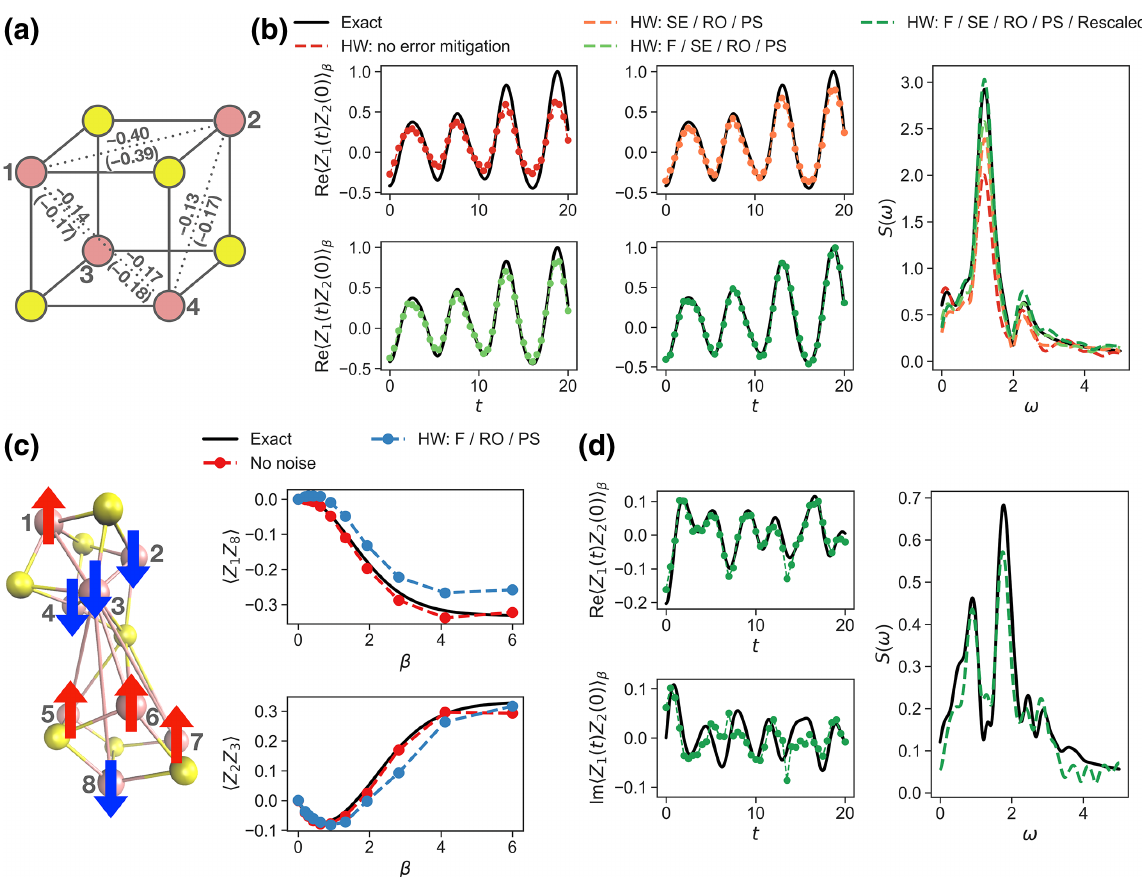
FIG. 3. (a) The finite-temperature (cid:2) Z i Z j (cid:3) ( β = 2) correlation functions computed for the [4Fe-4S] model. The simulation values are in good agreement with the exact results in parentheses. (b) The finite-temperature dynamical correlation function (cid:2) Z 1 ( t ) Z 2 ( 0 ) (cid:3) β ( β = 2) and its Fourier transform for the [4Fe-4S] model. (c) The spin-coupling pattern (derived from (cid:2) Z i Z j (cid:3) correlation functions) in the P-cluster and/or Fe-Mo–cofactor model and the simulated finite-temperature (cid:2) Z 1 Z 8 (cid:3) and (cid:2) Z 2 Z 3 (cid:3) for the model, showing the correct magnetic coupling pattern in the low-temperature regime. The deviation between the exact and no-noise results shows the effects of recompilation. (d) The real and imaginary parts of the finite-temperature dynamical correlation function (cid:2) Z 1 ( t ) Z 2 ( 0 ) (cid:3) β ( β = 1) and its Fourier transform for the P-cluster and/or Fe-Mo–cofactor model. Error-mitigation acronyms: SE, spin echoes; F, Floquet calibration; RO, readout-error mitigation; PS, postselection; HW, hardware. fidelity of > 90% in classical noiseless emulations [see Fig.